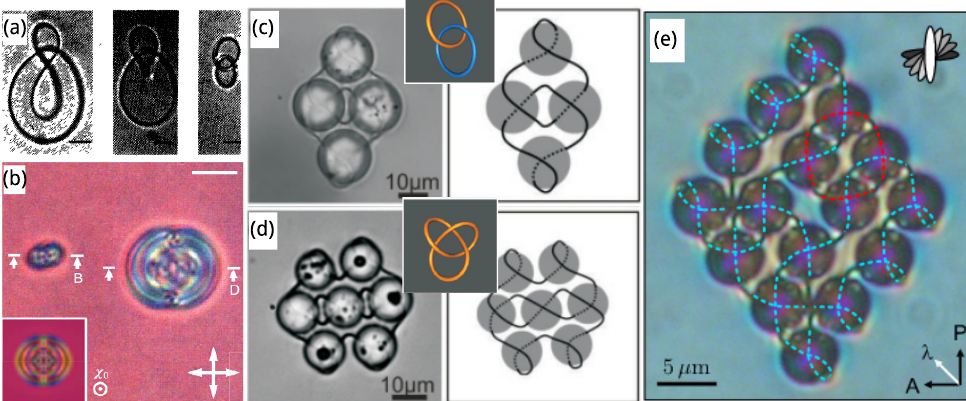
Figure 5. Knotted and linked disclinations in cholesterics and nematics. ( a ) Transient linked cholesteric disclinations, observed by Yves Bouligand. ( b ) A stable knotted cholesteric disclination, by Tai et al. ( c , d ) Linked and knotted disclinations stabilized by silica microspheres in a π -twisted cell. ( e ) A complex link stabilized in a π /2-cell on a nematic 2D colloidal crystal grid. The images are reprinted and adapted with permission from the references: ( a ) [123]–Copyright (1974) EDP Sciences, ( b ) [124]–Copyright (2019) AAAS, ( c , d ) [125]–Copyright (2011) APS. ( e ) [109]–Copyright (2015) National Academy of